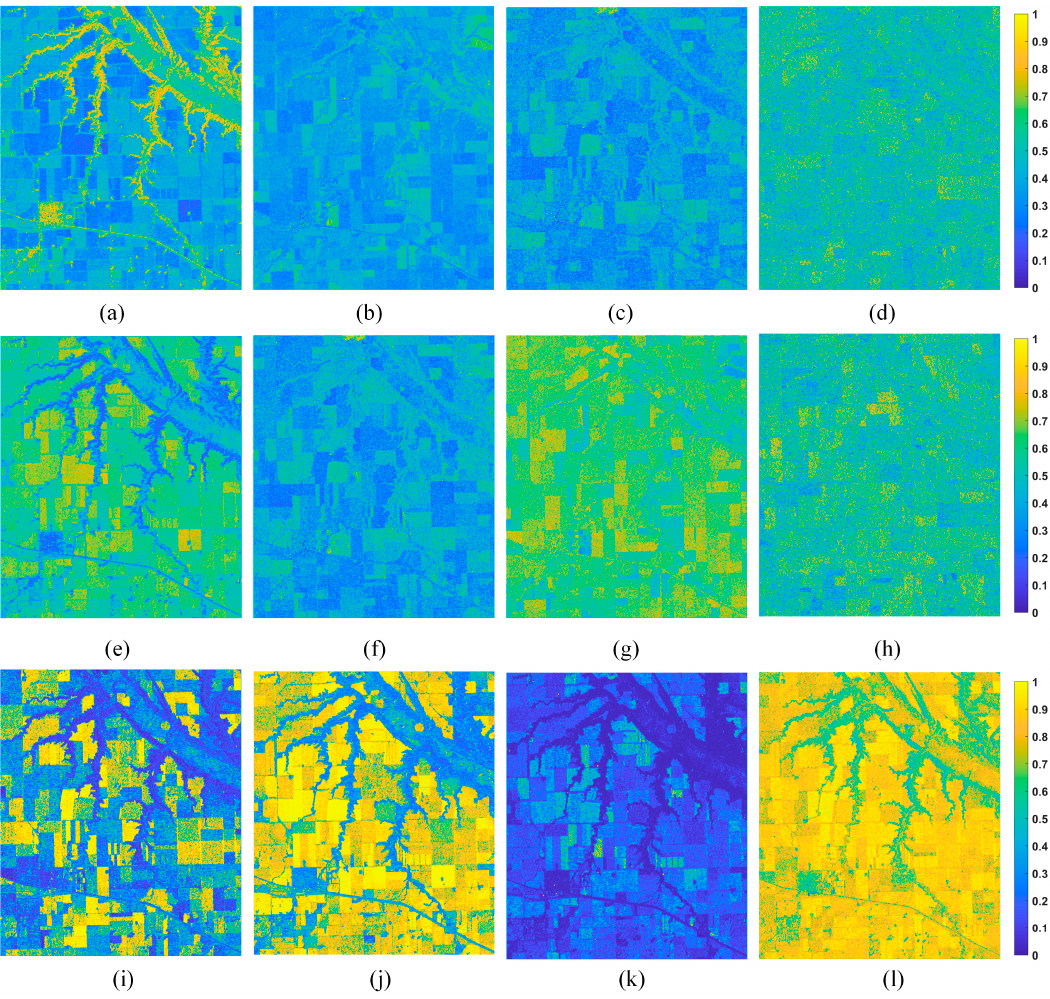
Figure 15. Visualization of the dimensionality reduction features: the first row gives the features of PCA, the second row gives the features of LLE, and the third row gives the features of the S-SAE.